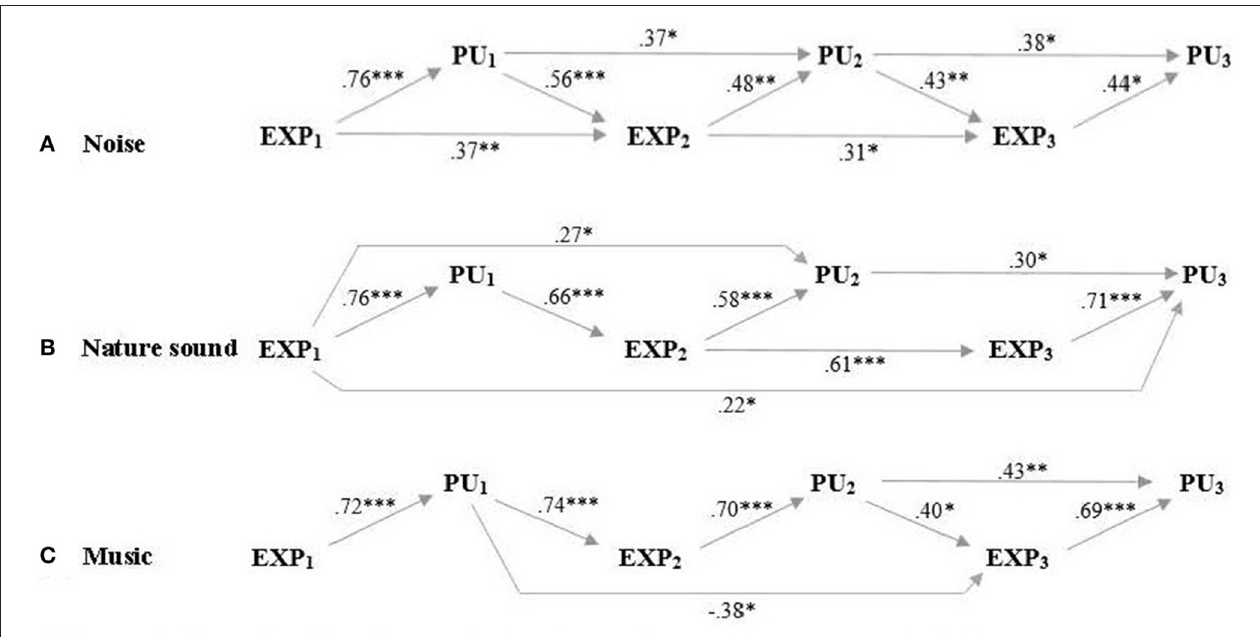
FIGURE 5 | Perceived and expected pain unpleasantness across test days. Path regression analysis of expectancy ratings on the 3 test days (EXP 1 , EXP 2 , EXP 3 ) and perceived pain unpleasantness on the 3 test days (PU 1 , PU 2 , PU 3 ) as predictors for later expectancy and pain ratings when participants listened to (A) noise, (B) nature sound and (C) music. Arrows and beta-values mark significant predictions and demonstrate that expected pain unpleasantness predicted perceived pain unpleasantness on all respective test days when including all previous expectancy and pain unpleasantness ratings in the regression model. * p < 0.05; ** p < 0.01; *** p <